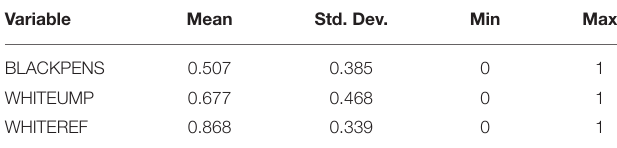
TABLE 2 | Game-level summary statistics ( N =